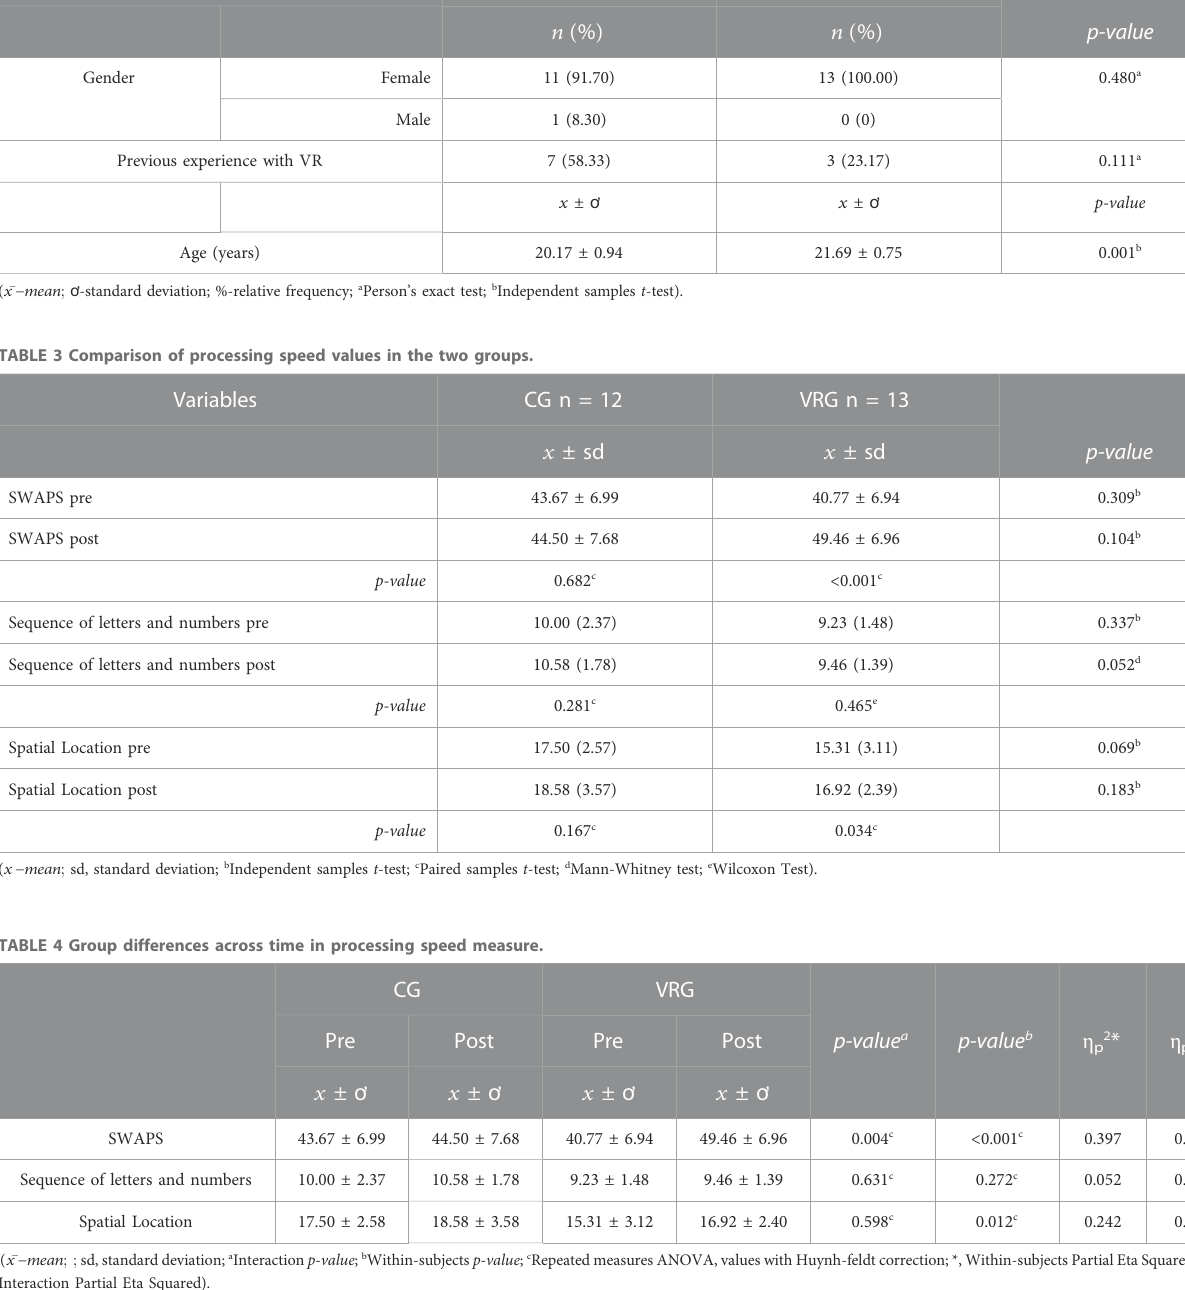
TABLE 2 Sociodemographic characterisation of the sample groups (CG and VRG) regarding age, gender and previous experience with VR. Groups variables